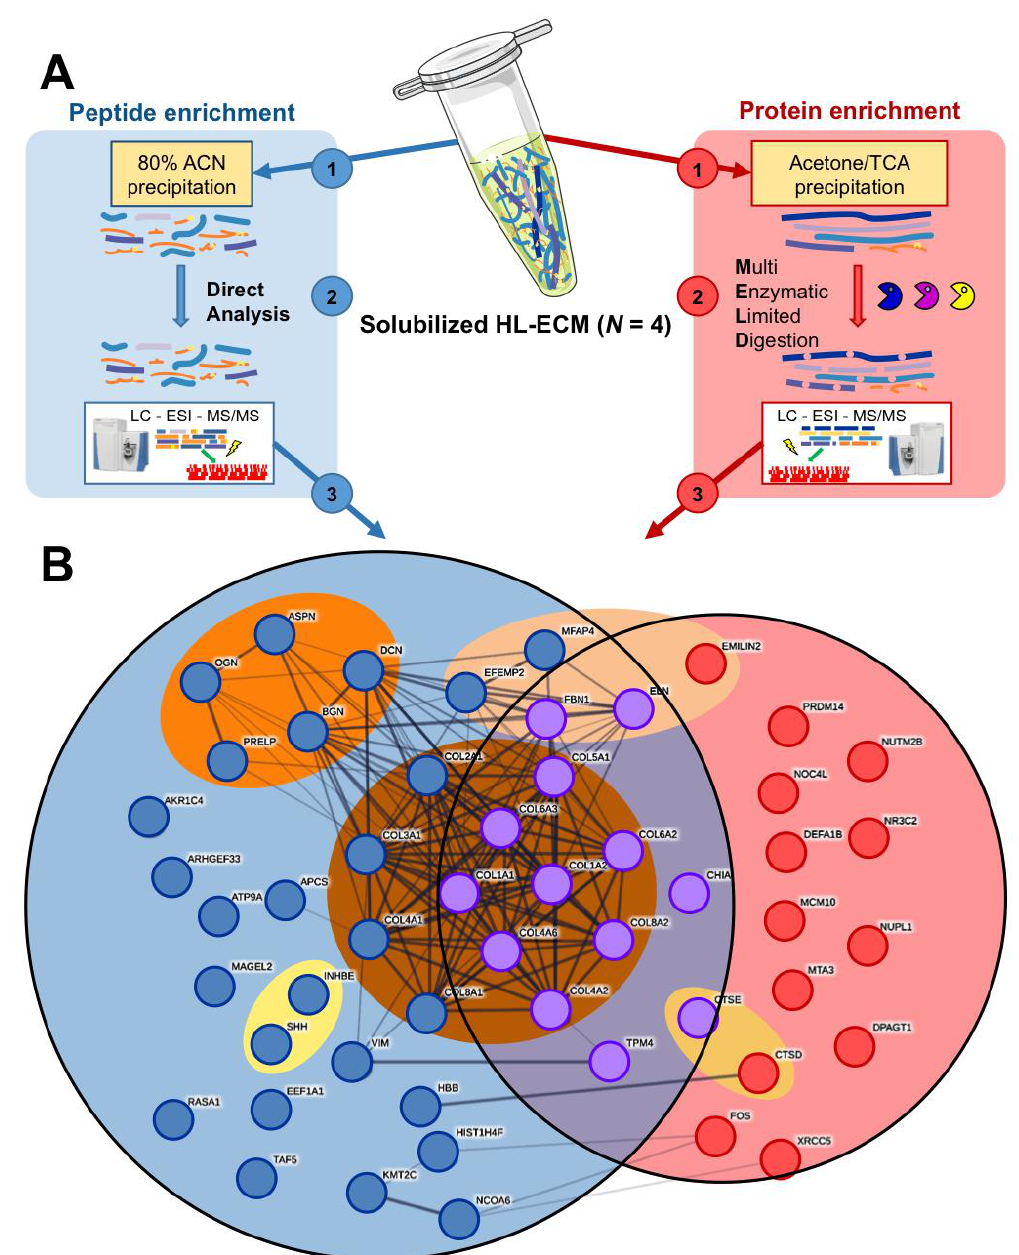
Figure 2. Composition of solubilized human liver extracellular matrix (HL-ECM). A proteomic analysis was performed on solubilized human liver extracellular matrix (HL-ECM), derived from 4 donors (154, 155, 158 and 159). ( A ) Schematic representation of the methodology applied to separately analyze peptide- and protein-enriched fractions. ( B ) String plot of the 52 proteins identified by mass spectrometry in the solubilized HL-ECM: each circle represents 1 protein; each line represents 1 identified protein–protein interactions in the String database; blue, red and purple filling indicate whether the protein was identified in the peptide, protein or both fractions; proteins were grouped in sets proposed in the Matrisome project. ACN: acetonitrile, ESI: electrospray ionization, LC: liquid chromatography, MS: mass spectrometry, TCA: trichloroacetic